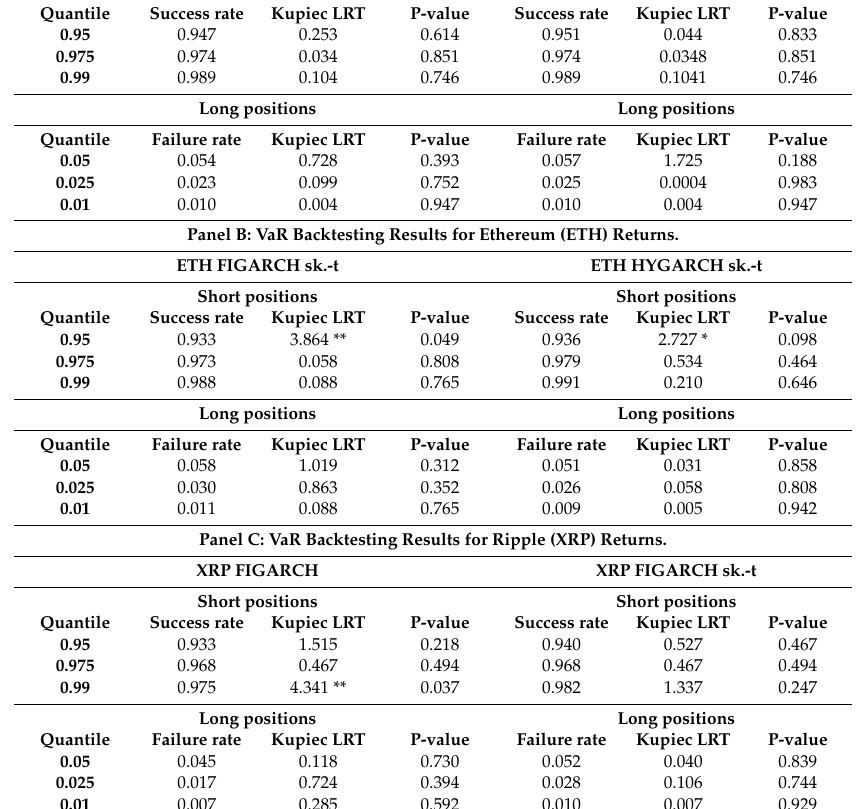
Short positions